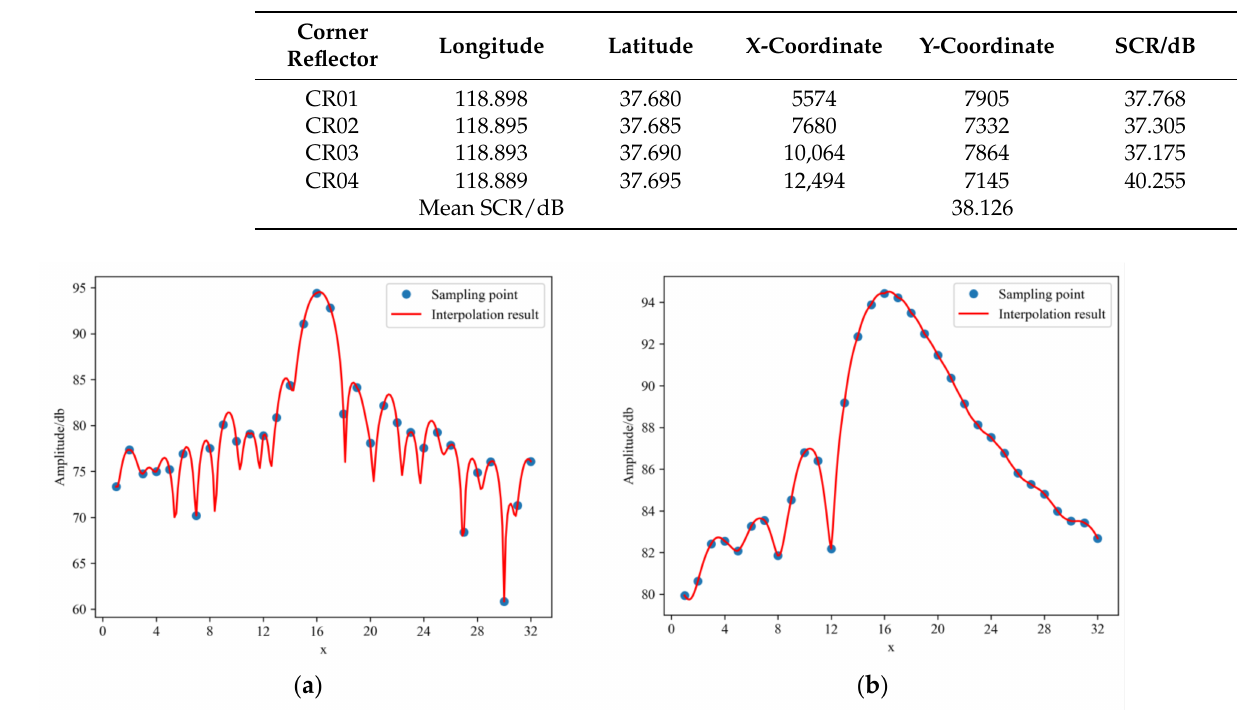
Table 5. Coordinates and SCR statistics corresponding to each point target in the VV polarimetric image.